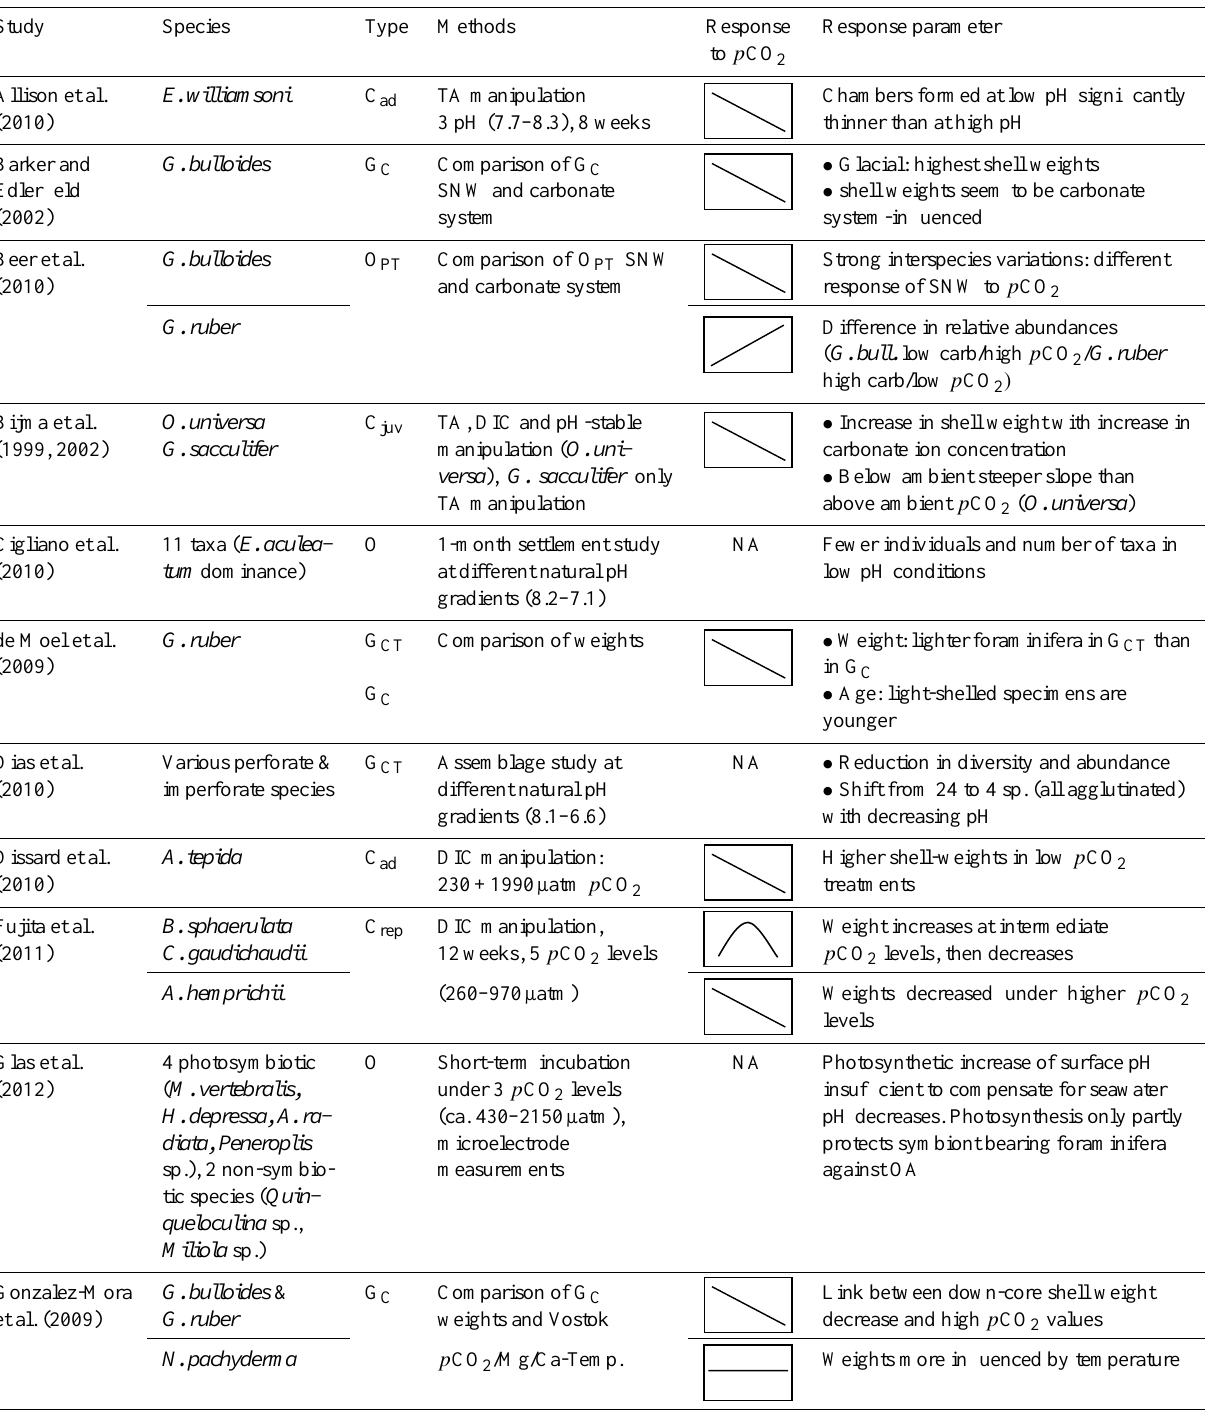
Table 3. Overview of foraminiferal response patterns to changes in carbonate chemistry. Responses are represented by simple trend plots. pH, p CO 2 and other carbonate system parameters covary in TA and DIC manipulation studies. This renders it possible to read off the respective p CO 2 response, where not directly given, to enhance comparability. Analyzed parameters vary by study: shell weight, SNW (size-normalized weight), size, growth/calcification rates (see Sect. 4.2) and shell thickness. Responses are represented by simple trend plots. Those studies assessing the affects of OA on foraminiferal communities (diversity, abundance) have not been depicted by these trend plots (NA – not applicable). The studies were categorized as follows: G=geological record (G CT =core tops, G C =down core), O=open ocean (O ST =sediment trap, O PT =plankton tow), C=culture experiments (C rep =asexually reproduced individuals, C ad / juv =adult/juvenile individuals collected from their natural habitat), and O=other